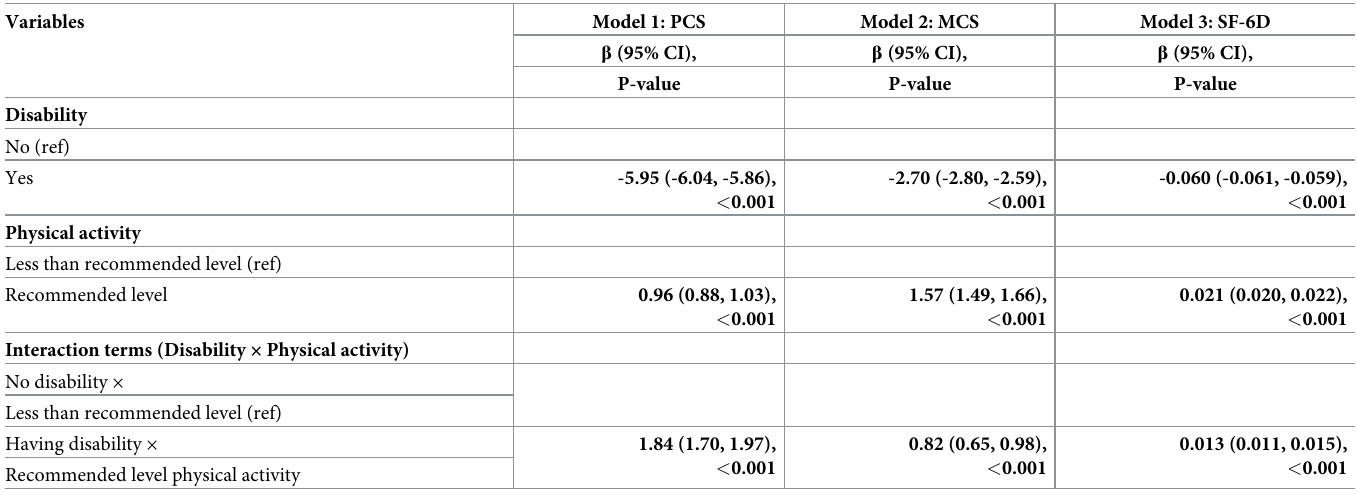
Table 4. The relationship between disability and physical activity with the SF-36 component summary scores and SF-6D utility score, random-effects GLS regression.